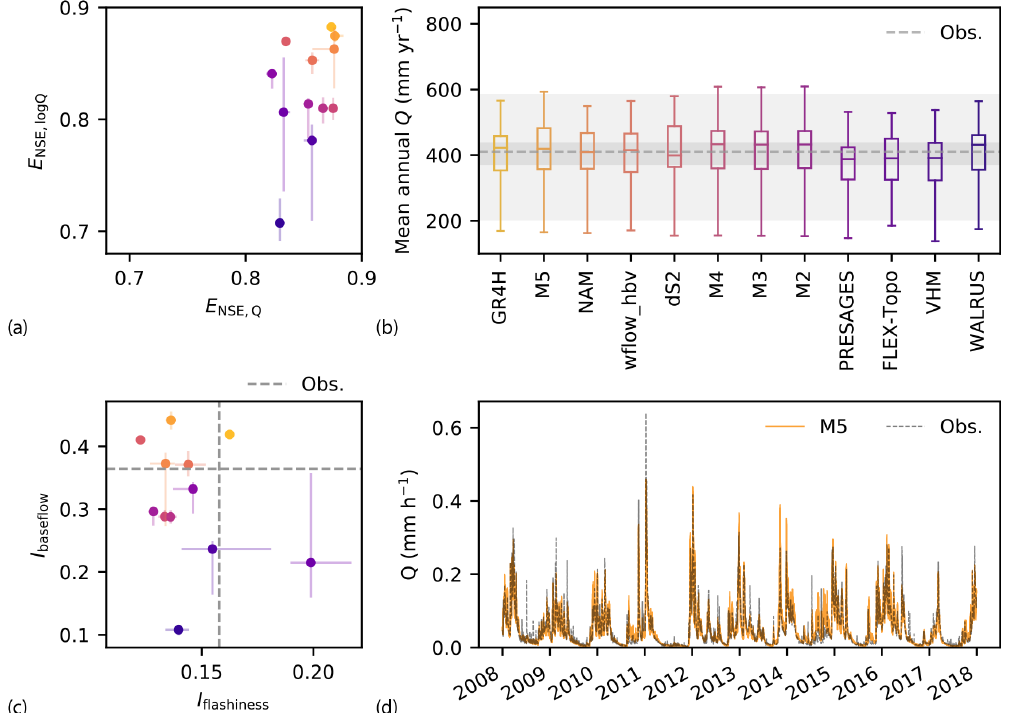
Figure 3. Evaluation of modeled streamflow performance for the Ourthe at Tabreux for the period 2008–2017. (a) Nash–Sutcliffe efficiencies of the streamflow E NS , Q and the logarithm of the streamflow E NS , logQ (median, 25th/75th percentiles across parameter sets). (b) Modeled mean annual streamflow for hydrological years between 2008 and 2017 across feasible parameter sets. The models are ranked from the highest to the lowest performance according to the Euclidean distance of streamflow performance (see Table 2). The dashed line and grey shaded areas show median, 25th/75th and minimum–maximum range of observed mean annual streamflow. (c) Baseflow index I baseflow as a function of the flashiness index I flashiness (median, 25th/75th percentiles across parameter sets). Observed values are shown by the grey dashed lines. (d) Observed and modeled hydrographs of model M5 with high streamflow model performance (low Euclidean